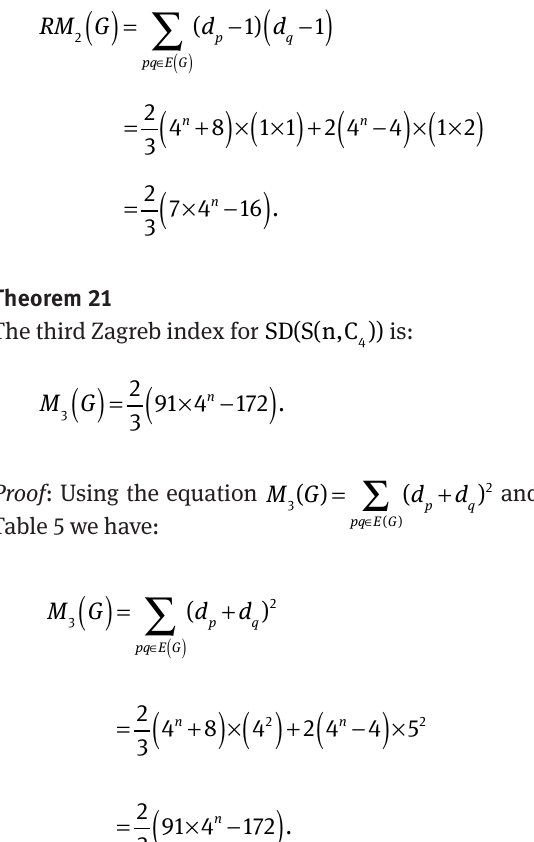
Table 5: The partition E(G) of SD ( S ( n , C ( d , d ) (2,2) (2,3) p q Number of